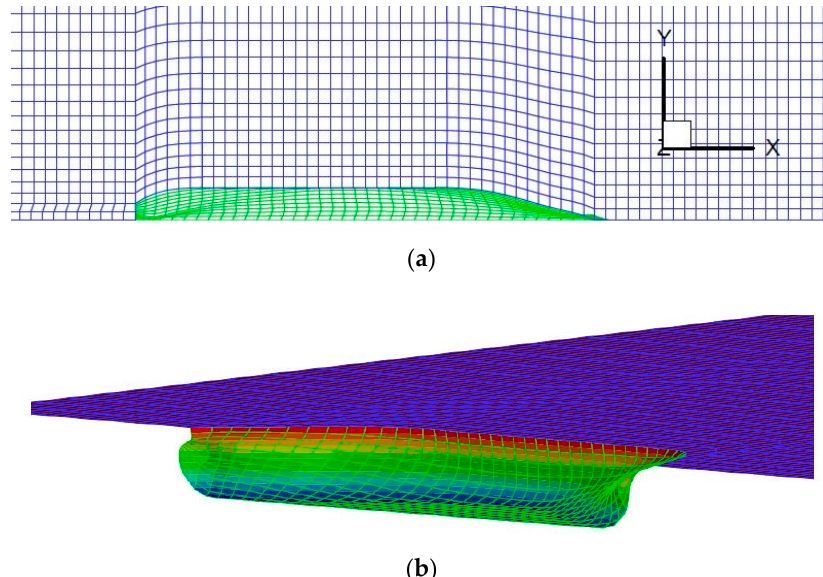
Figure 5. Spline sheet on the computational greed ( a ) free surface; ( b ) body surface.